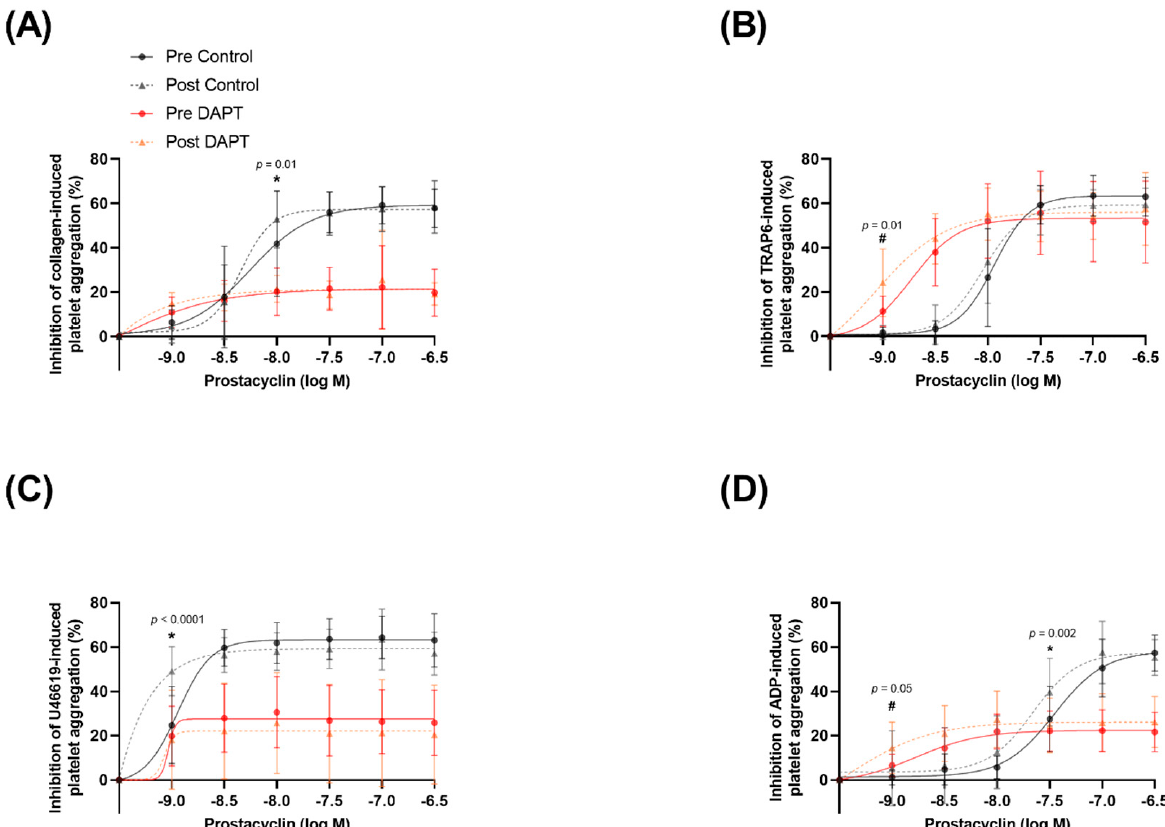
Figure 4. Platelet sensitivity to the anti-aggregatory effects of prostacyclin (1–300 nM), with and without dual anti-platelet therapy (DAPT). Agonist-induced platelet aggregation to ( A ) 10 µ g · mL − 1 collagen ( n = 12), ( B ) 10 µ M thrombin receptor activator peptide 6 (TRAP6) ( n = 13), ( C ) 20 µ M adenosine 5 (cid:48) -diphosphate (ADP) ( n = 12), and ( D ) 10 µ M U46619 ( n = 12). *, indicates a statistically significant decrease with training with the control treatment. #, indicates a statistically significant decrease with training with the DAPT